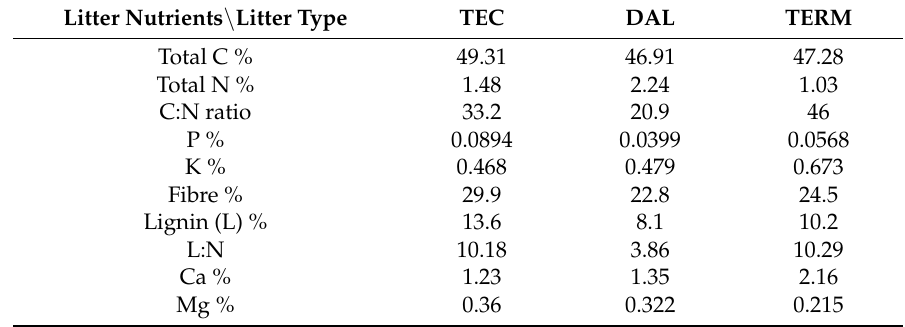
Table 2. Litter properties of the three species used in a decomposition study in Panama, Central America; where TEC is Tectona grandis litter, DAL is Dalbergia retusa litter and TERM is Terminalia amazonia litter. The values shown are from one composite sample ( n = 1) per litter type for total carbon (C), nitrogen (N), phosphorus (P), potassium (K), C:N ratio, fibre, lignin (L), L:N ratio, calcium (Ca), and magnesium (Mg).